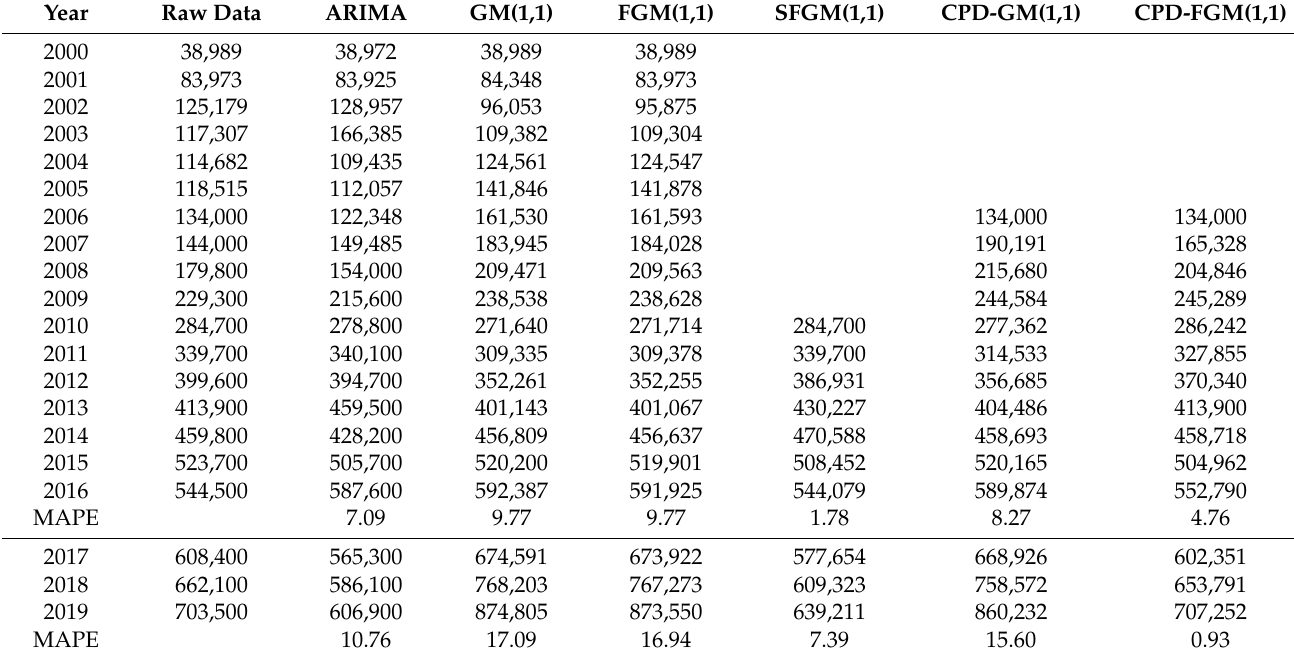
Table 2. The results for students studying abroad prediction.